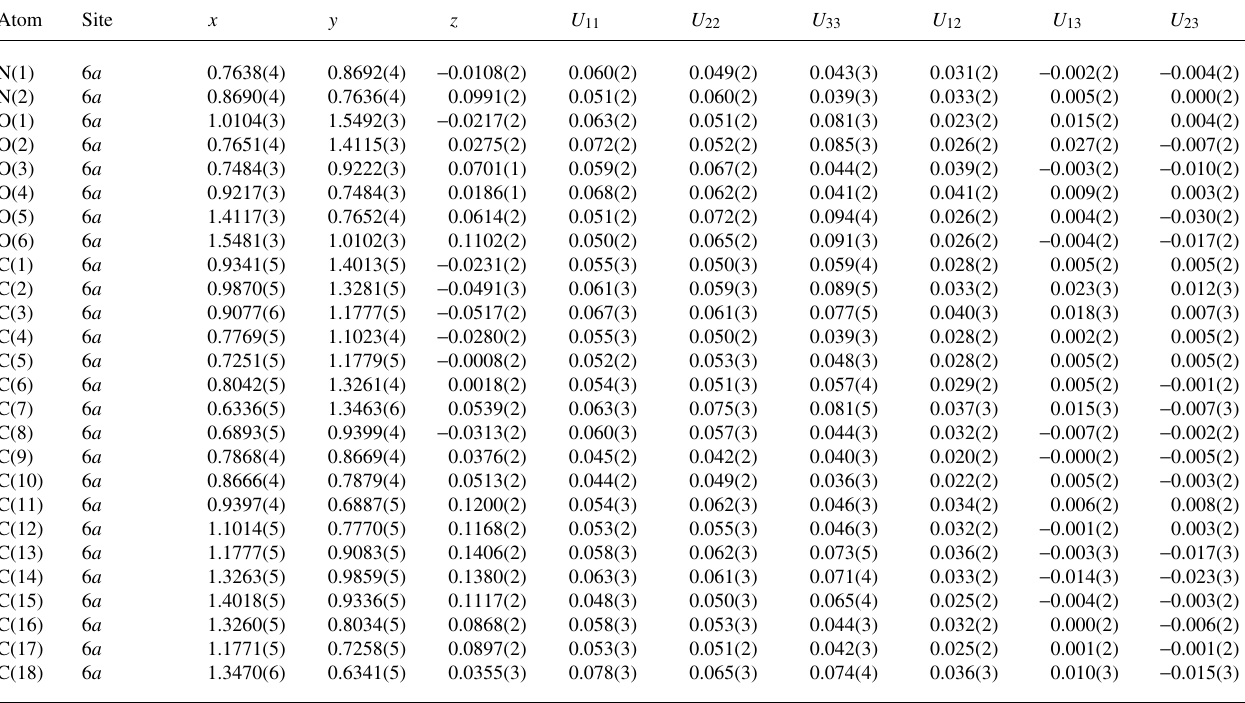
Table 3. Atomic coordinates and displacement parameters (in Å 2 ) .